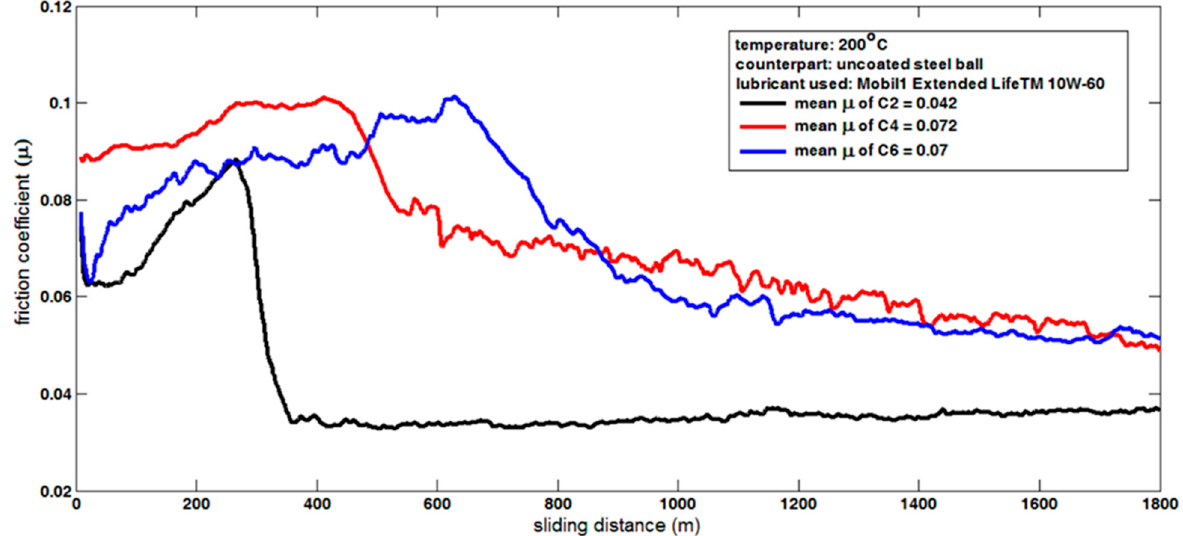
Figure 8. Friction behavior of C2, C4 and C6 in lubricated condition against steel balls at 200 °C .